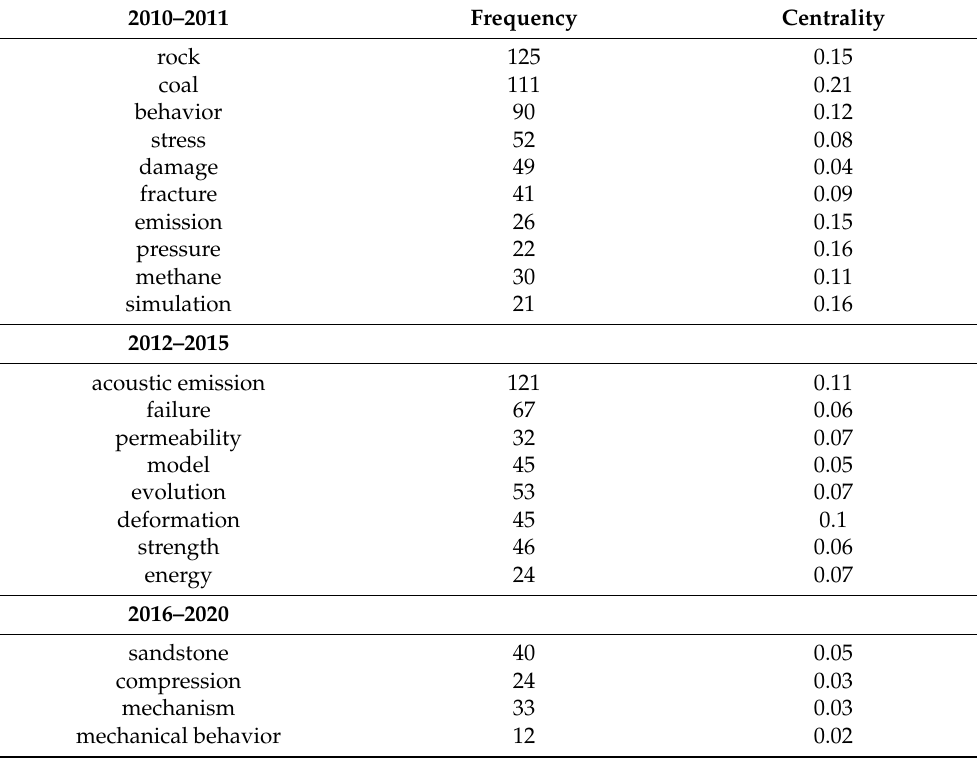
Figure 10. Time-zone view of the keyword cooccurrence network. Table 3. Analysis of keyword three-stage